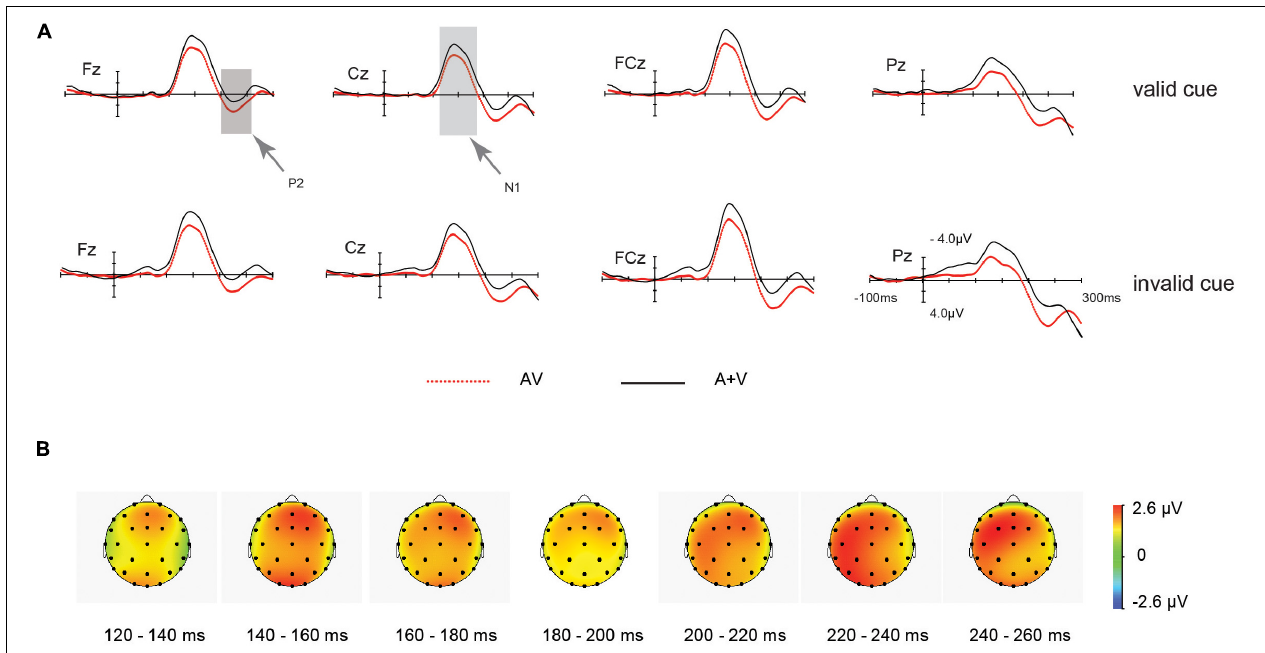
FIGURE 4 | ERP waveform for the unisensory and multisensory (AV) late processing. (A) Grand average ERPs of differences between AV (red dotted line) and A + V (black solid line) conditions for valid and invalid cue stimuli. (B) Scalp topographies from 120 to 260 ms after the onset of the stimulus for the different waves of the multisensory (AV) and the summed (A + V) ERP responses, indicating multisensory integration effect for valid and invalid